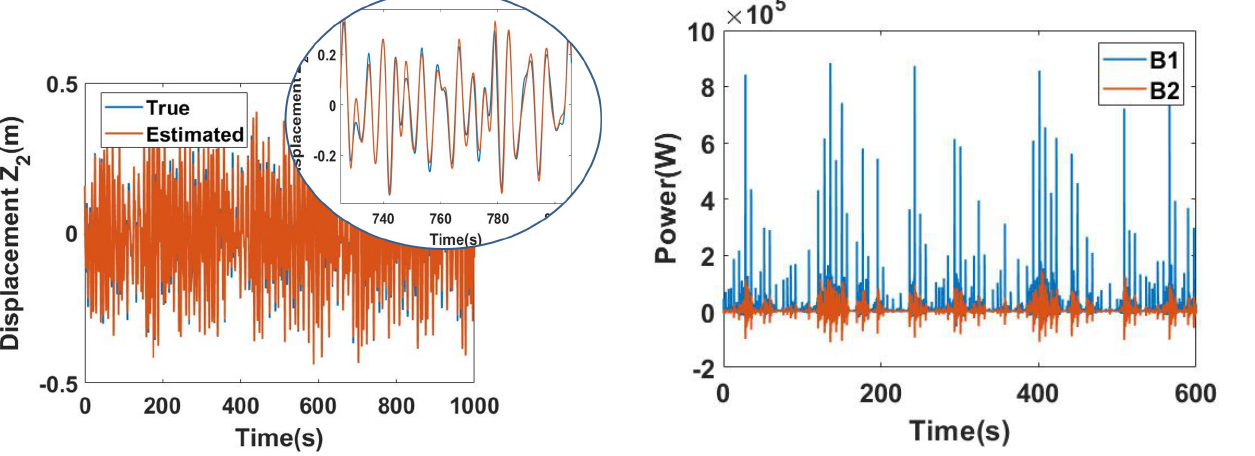
Fig. 10: The power extracted by applying switching control Fig. 7: The estimation of the displacement ( z 2 ) of the second with control limitation 5 × 10 5 N under the wave condition mass. H s = 3 . 8 m and T p = 16